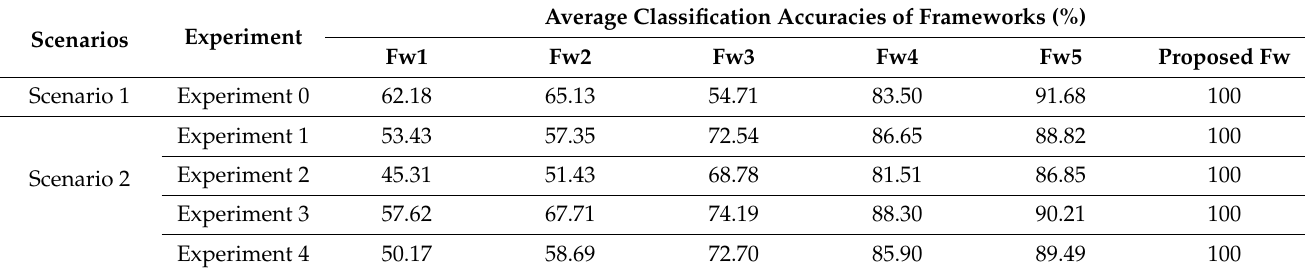
Table 6. The overall identification accuracies of the compared frameworks through two